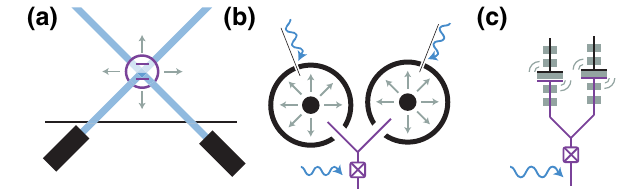
FIG. 1. Sketch of the possible platforms for the implemen- tation of two-mode grid codes. (a) Motional modes (gray) of a trapped ion (purple), with lasers used for control (blue). (b) Two single-post microwave cavities (black), coupled to a trans- mon qubit (purple). Electromagnetic modes (gray) are controlled through pulses (blue) applied on the cavities and transmon qubit. (c) Phononic-crystal-defect resonator modes (gray) coupled to a transmon qubit